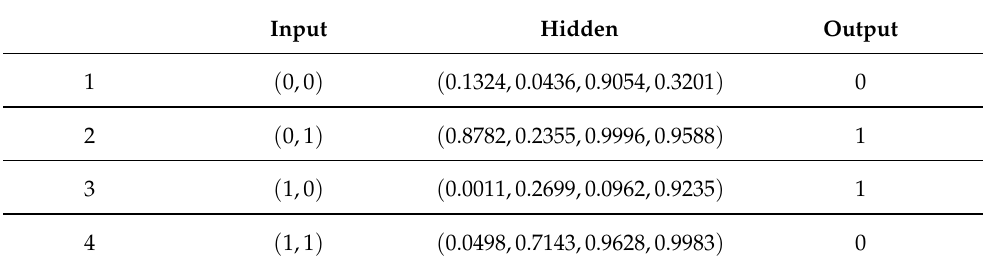
Table 8. The values of input, hidden, and output neurons for the “XOR” data set. Input Hidden Output 1 ( 0,0 )